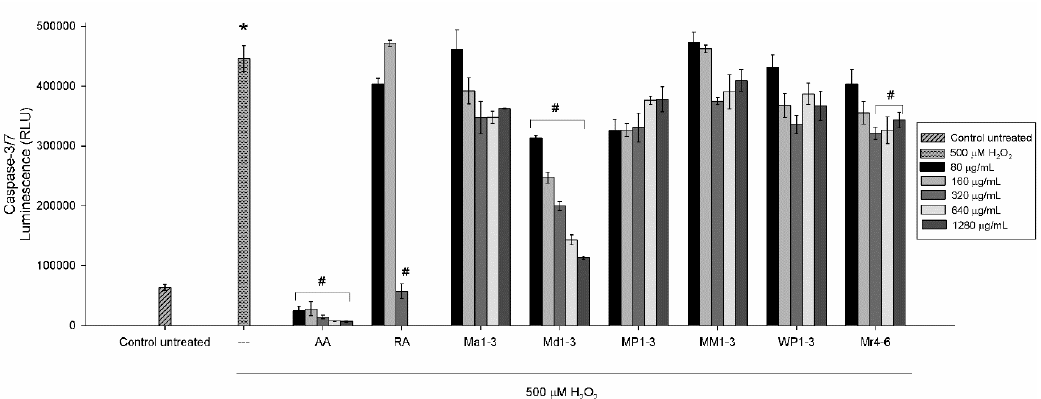
Figure 3. Neuroprotective effect of different concentrations of ascorbic acid, rosmarinic acid and mint extracts on caspases-3/7 activity in H 2 O 2 -induced damage in SH-SY5Y cells. Results are presented as mean ± standard error (SE) ( n = 3). * indicates that treatment with H 2 O 2 is significantly different ( p < 0.05) from control untreated cells, # indicates that pretreatment with mint extracts, AA or RA is significantly di ff erent ( p < 0.05) from H 2 O 2 -treated cells. AA: ascorbic acid, RA: rosmarinic acid,